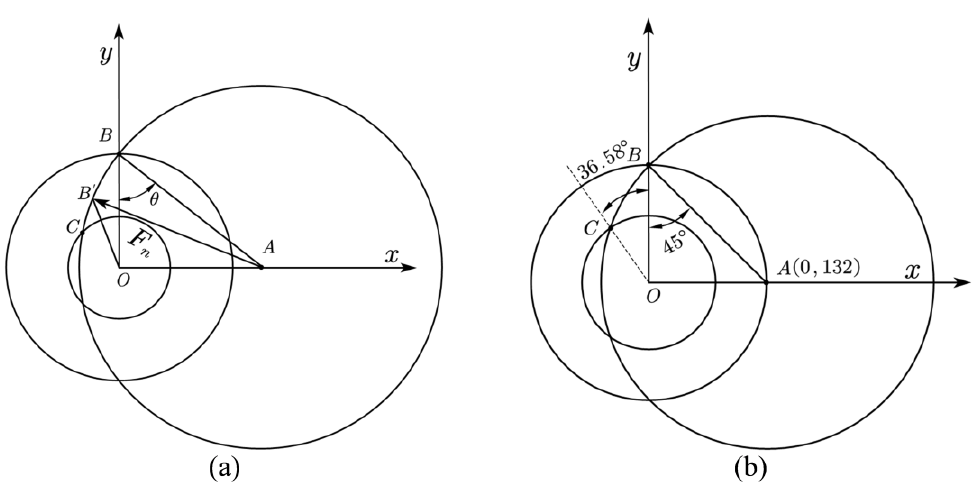
Figure 17. ( a ) Circumferential chute curve trajectory; ( b ) Circumferential chute curve trajectory after determining parameters.